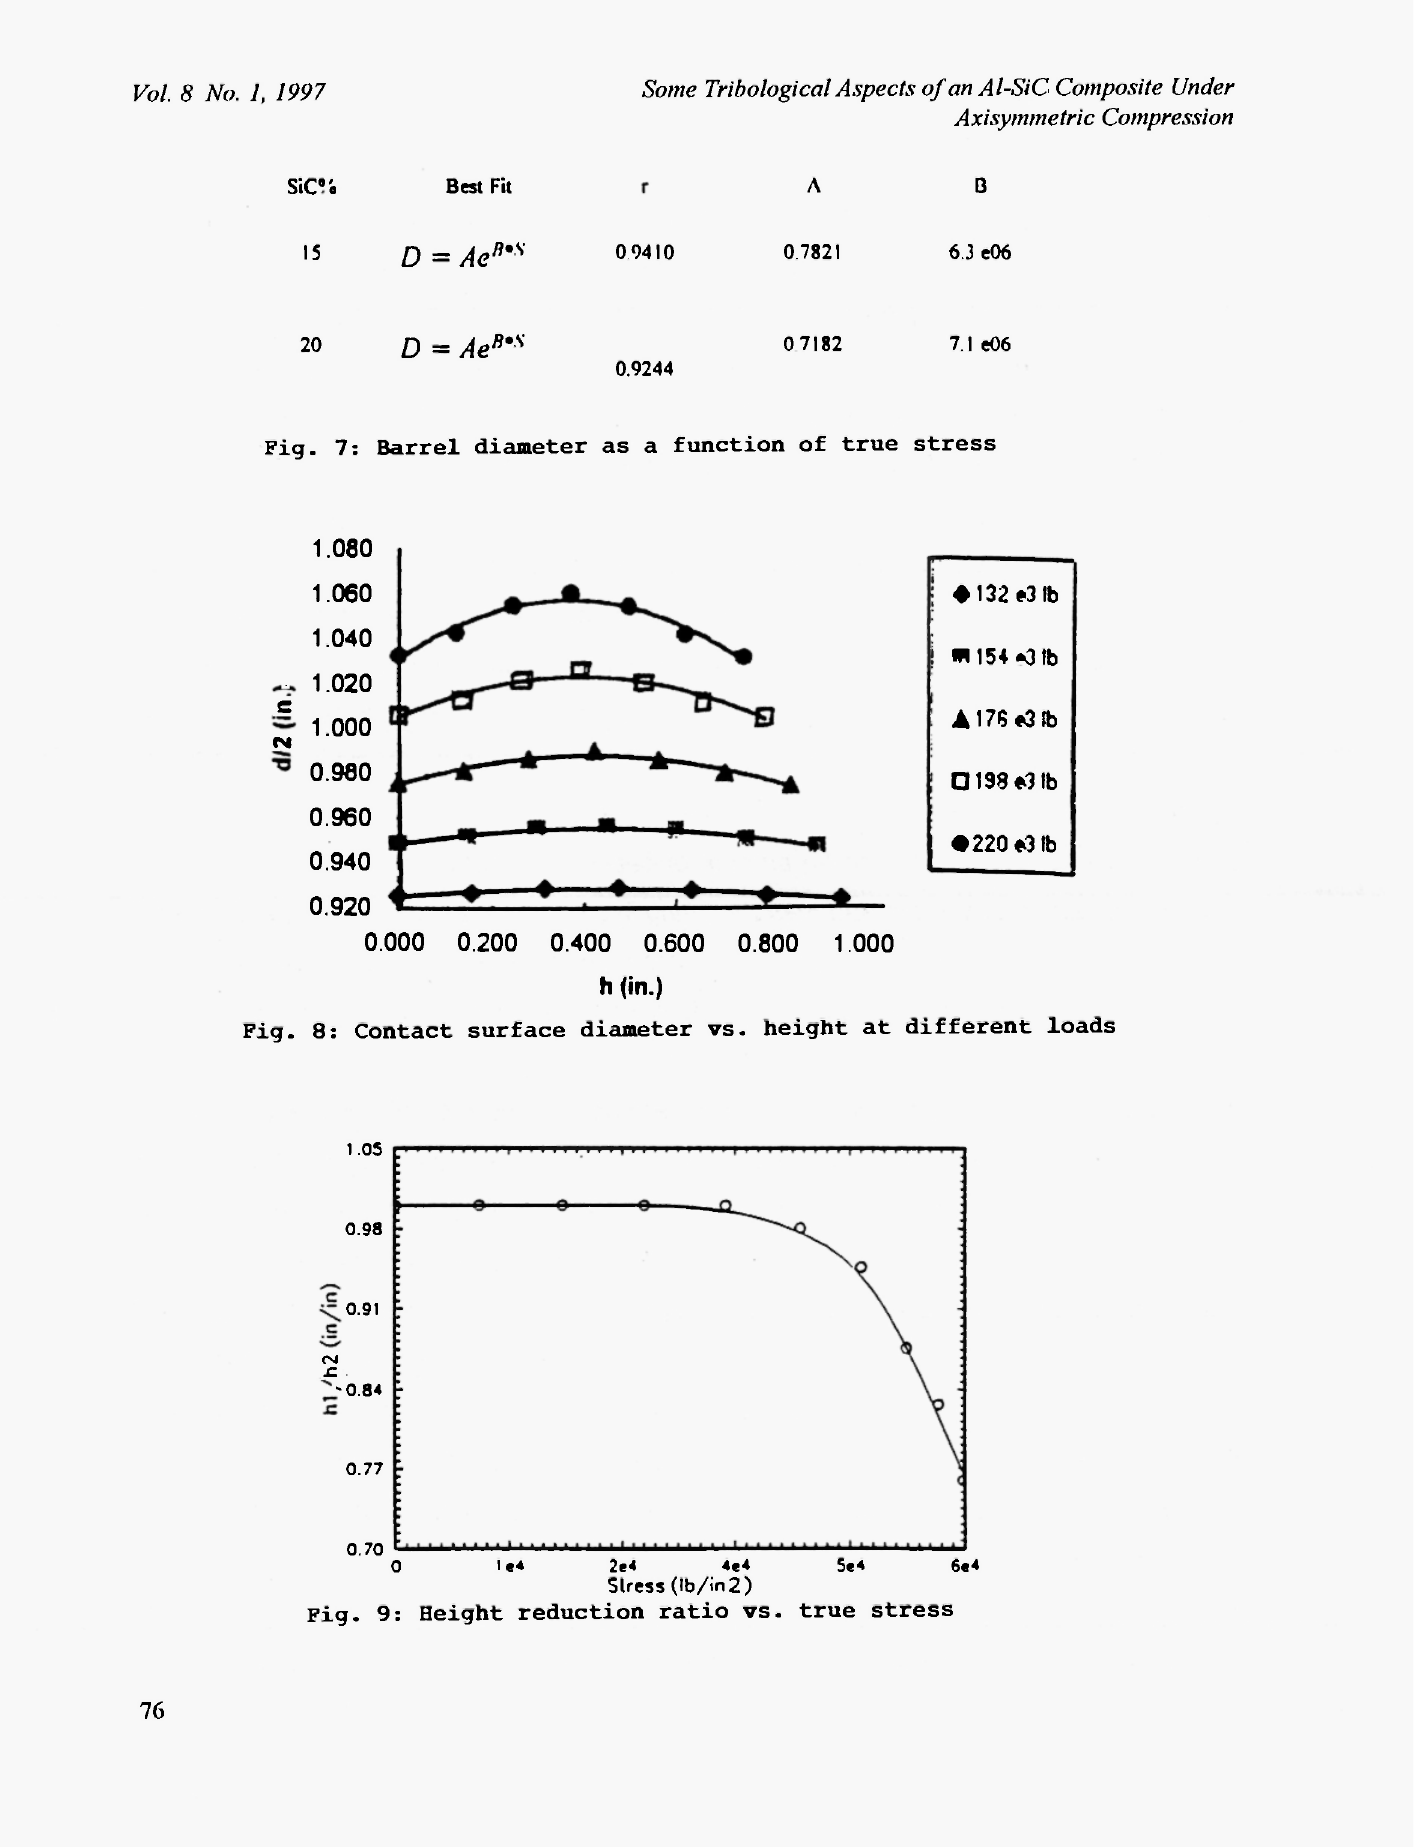
Fig. 7: Barrel diameter as a function of true stress